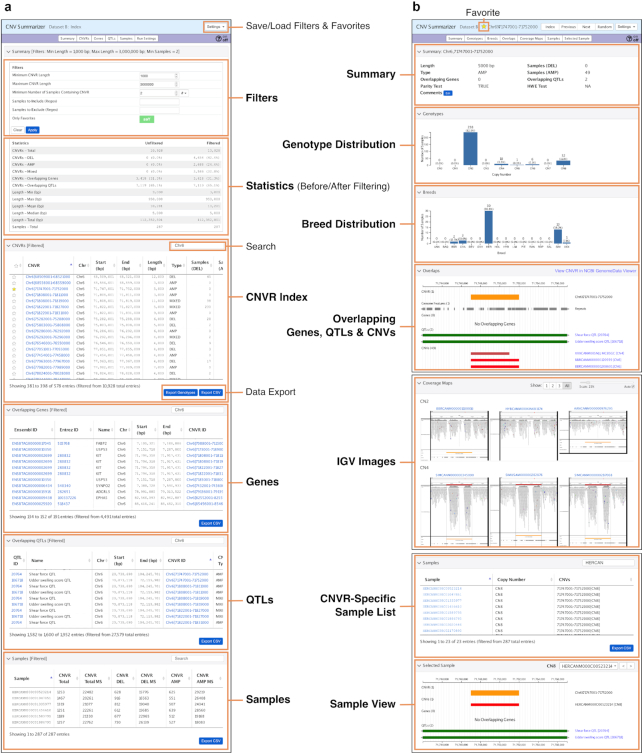
Key features of the functionality of the CNVR database. The database has an index view and a detailed view with an option to enable/disable the help function on the top right of each page. The index page (a) has a panel (Filters) that allows users to apply filters to the CNVRs such as CNVR length or the number of samples that must contain the CNVR and the ability to exclude/include specific samples based on regular expression matches. Another panel (Statistics) provides summary information on the CNVRs before and after applying the filters. The remaining panels on the index page allow users to search and sort on CNVRs, overlapping genes, and QTLs and/or samples to quickly find CNVRs associated with a particular gene/QTL. All or selected data can be exported as CSV files. CNVRs of interest can be noted as favorites; and comments can be added for individual CNVRs. All comments, filters, and/or favorites can be saved as a text file that can be reloaded later using the Settings button options on the top right of the page. Clicking on a CNVR provides a detailed view (b) with panels displaying basic statistics on the CNVR (Summary), a bar plot of the number of samples per CNV genotype (Genotype distribution), and another bar plot of the number of non-CN2 variants per breed (Breed distribution), graphical representation of the CNVR in genomic context (Overlapping genes, QTLs, and CNVs), sequence read coverage at the CNVR for up to 3 samples per genotype (IGV images), a table of all the samples indicating the CNV genotype (CNVR-specific sample list), and finally a sample view that provides, for the selected sample, a graphical representation of the CNVR and CNV in genomic context with overlapping genes and QTLs.